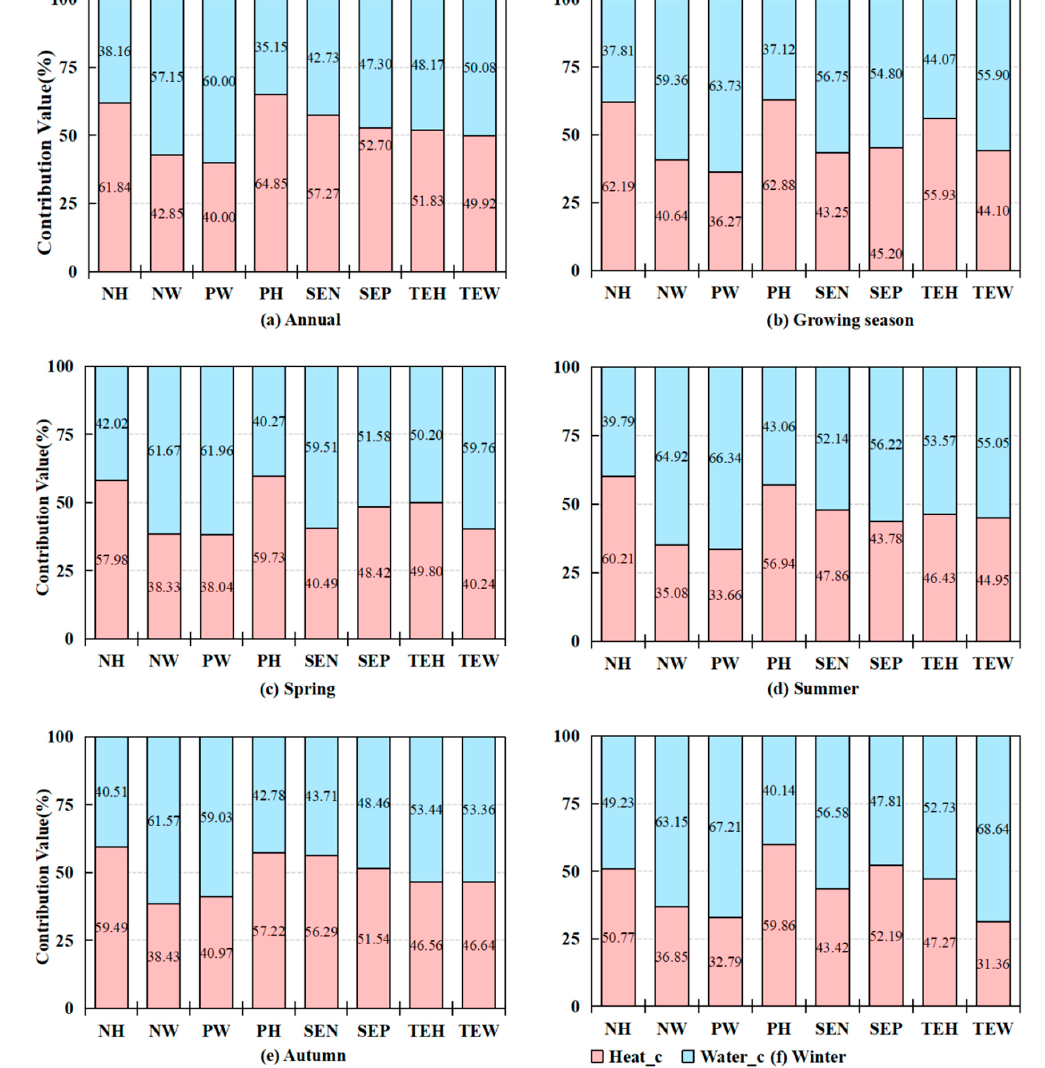
Figure 7. The average contribution value of heat and water conditions under different function types for the effect of hydrothermal conditions on vegetation growth. Heat_c represents the average contribution value of heat conditions under the influence of hydrothermal conditions’ tradeoffs and synergies. Water_c represents the average contribution value of heat conditions under the influence of hydrothermal conditions’ tradeoffs and